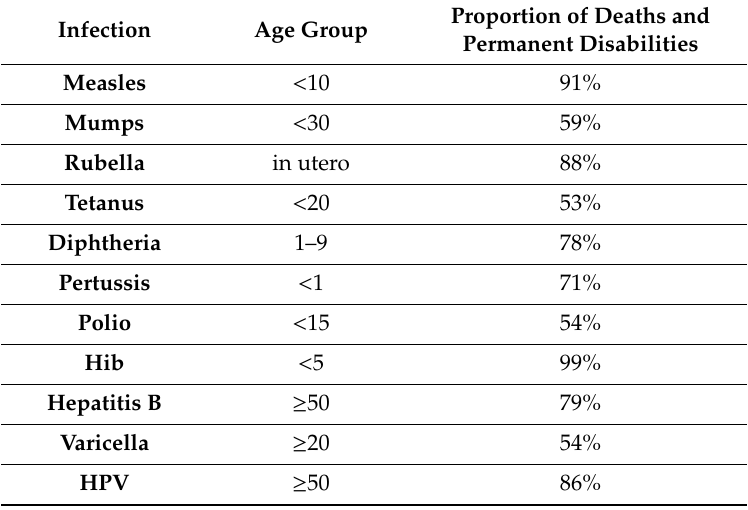
Table 2. Age groups that comprised the greatest proportion of deaths and permanent disabilities from various infectious diseases in the USA in the absence of mass vaccination.